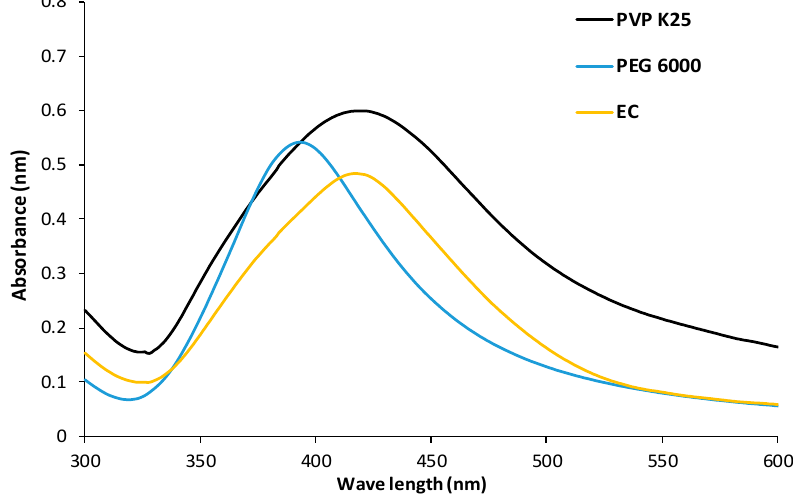
Figure 1. UV–VIS spectra for AgNPs-PVP, AgNPs-PEG, and AgNPs-EC.